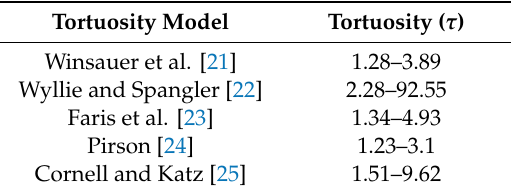
Table 5. Summary of measured petrophysical properties on 12 subsamples representing six wells and the different hydraulic flow units. FZI: flow zone indicator, RQI: reservoir quality index.